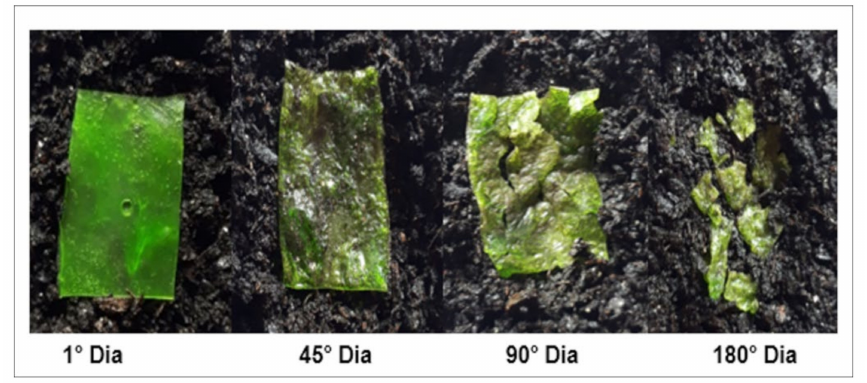
Figure 7. Biodegradation in soil.